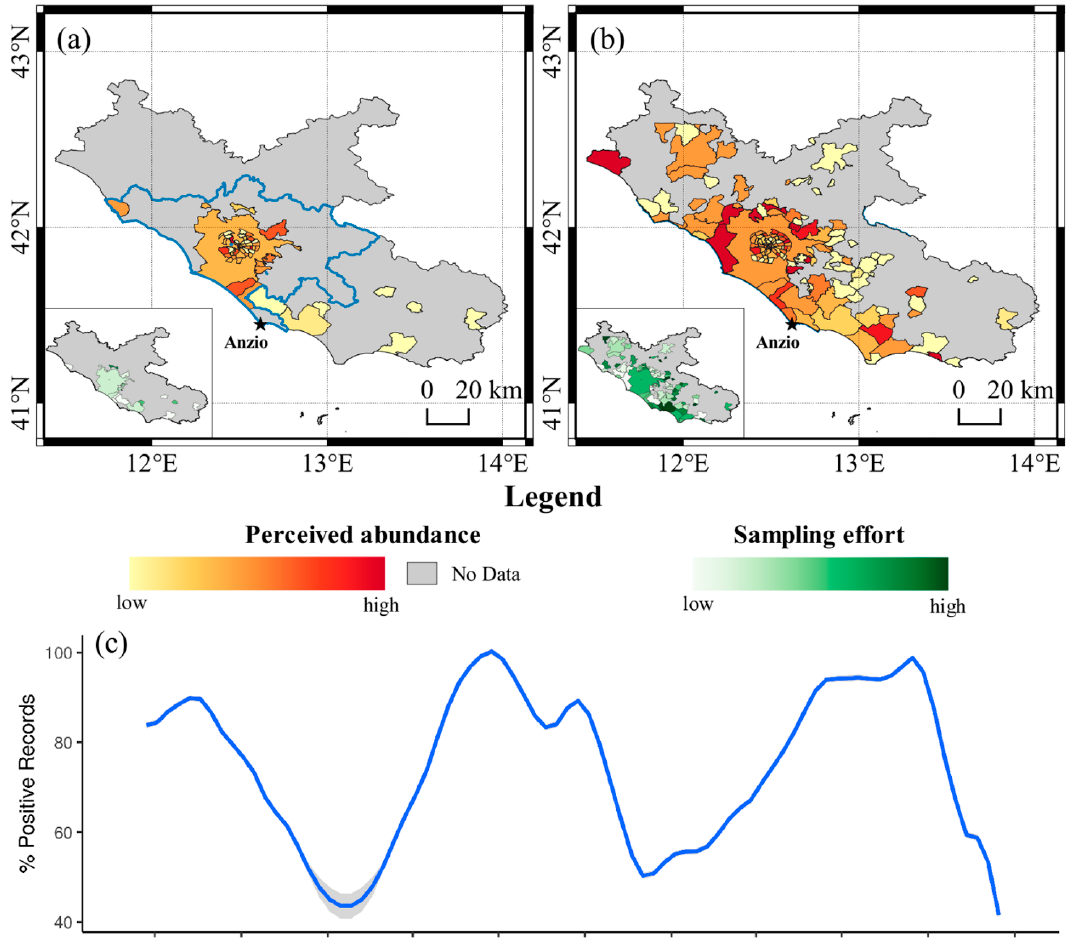
Figure 7. Scales of perceived mosquito abundance based on ZanzaMapp records aggregated for the Lazio region for the weeks 1 October 2017–7 October 2017 ( a ) and 8 October 2017–14 October 2017 ( b ). Inner squares represent maps of sampling effort, i.e., the ratio between number of ZanzaMapp records and human population. ( c ). Temporal profile of the percentage of positive records ( ≥ 1 mosquito) reported in the province of Rome in May 2016–December 2018. The grey area from January 2017–April 2017 refers to interpolated data, due to lack of ZanzaMapp records.